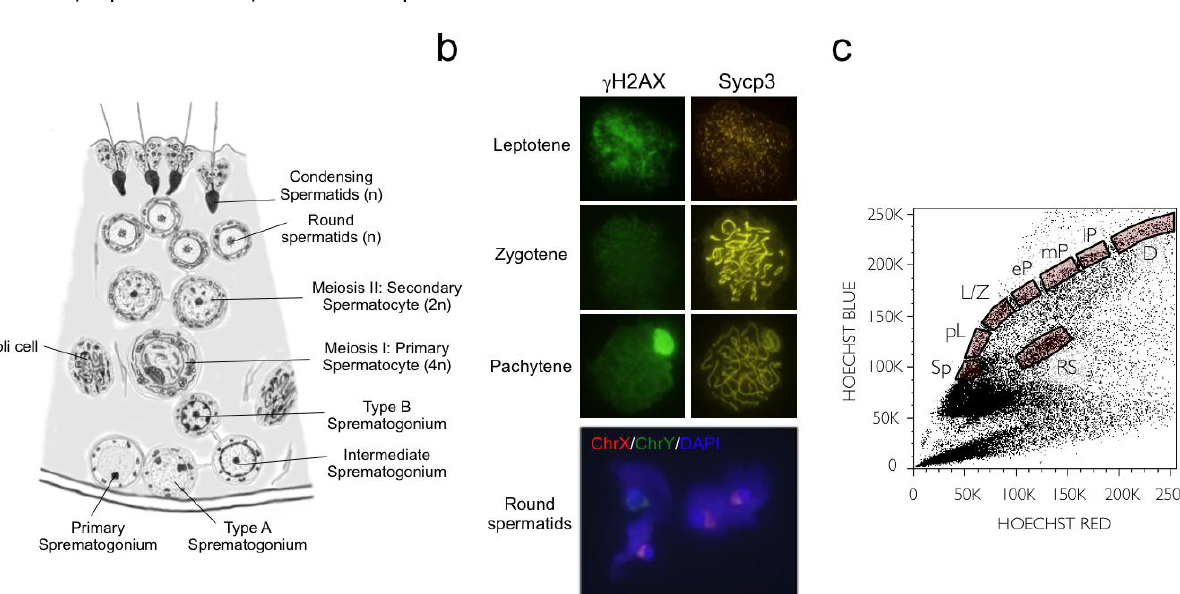
Figure 1. Architecture of the mammalian testis and purification of meiotic fractions. ( a ) Schematic drawing of a section of a seminiferous tubule with mitotic spermatogonia, spermatocytes, and spermatids surrounded by two Sertoli nurse cells; ( b ) Representative pictograms of FACS-purified meiosis prophase I meiotic stages labeled for phosphorylated histone H2AX and synaptonemal complex protein 3 (immunofluorescence analyses), as well as the split sexual chromosome in round spermatids (fluorescent in situ hybridization); ( c ) A representative Hoechst FACS profile is shown, with the various meiotic cell populations used in this study indicated: spermatogonia (Sp), pre-leptotene (pL), leptotene-zygotene (L/Z), early-pachytene (eP), middle-pachytene (mP), late-pachytene (lP), diplotene (D), and round spermatids